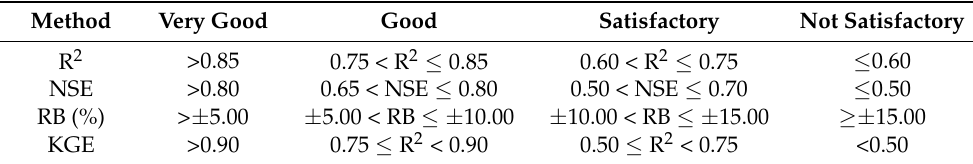
Table 2. Final SWAT performance rating as recommended by Moriasi et al. [44] and Kouchi et al.